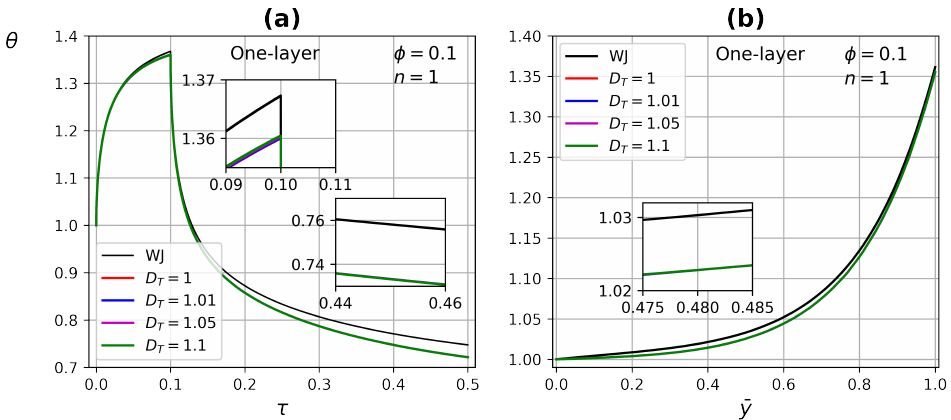
Figure 11. Temperature profiles as a function of ( a ) time and ( b ) tissue layer depth, for different D T values at τ =